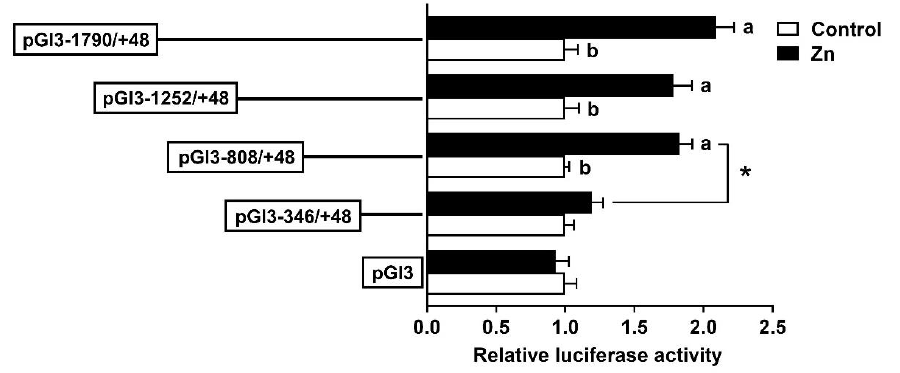
Figure 3. The 5 (cid:48) unidirectional deletion assays for promoter regions of SHP after 50 µ M Zn treatment. Values show the ratio of activities of firefly to Renilla luciferase normalized to the control. Results are presented as mean ± SEM ( n = 3). Asterisk (*) indicates significant differences between different 5 (cid:48) unidirectional deletion plasmids under the same treatment ( p < 0.05). Different letters indicate significant differences between the different treatments in the same plasmid ( p <